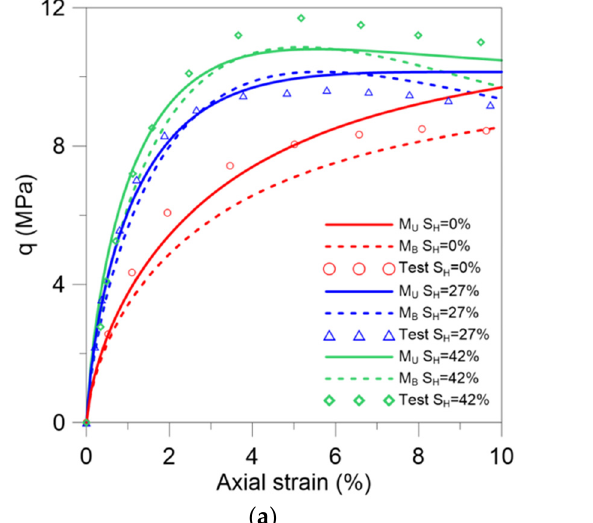
Figure 8. Modeling the tests reported in Hyodo et al. [6] at 𝜎 3 = 3 MPa. ( a ) Deviatoric stress versus axial strains; ( b ) volumetric strain versus axial strains.